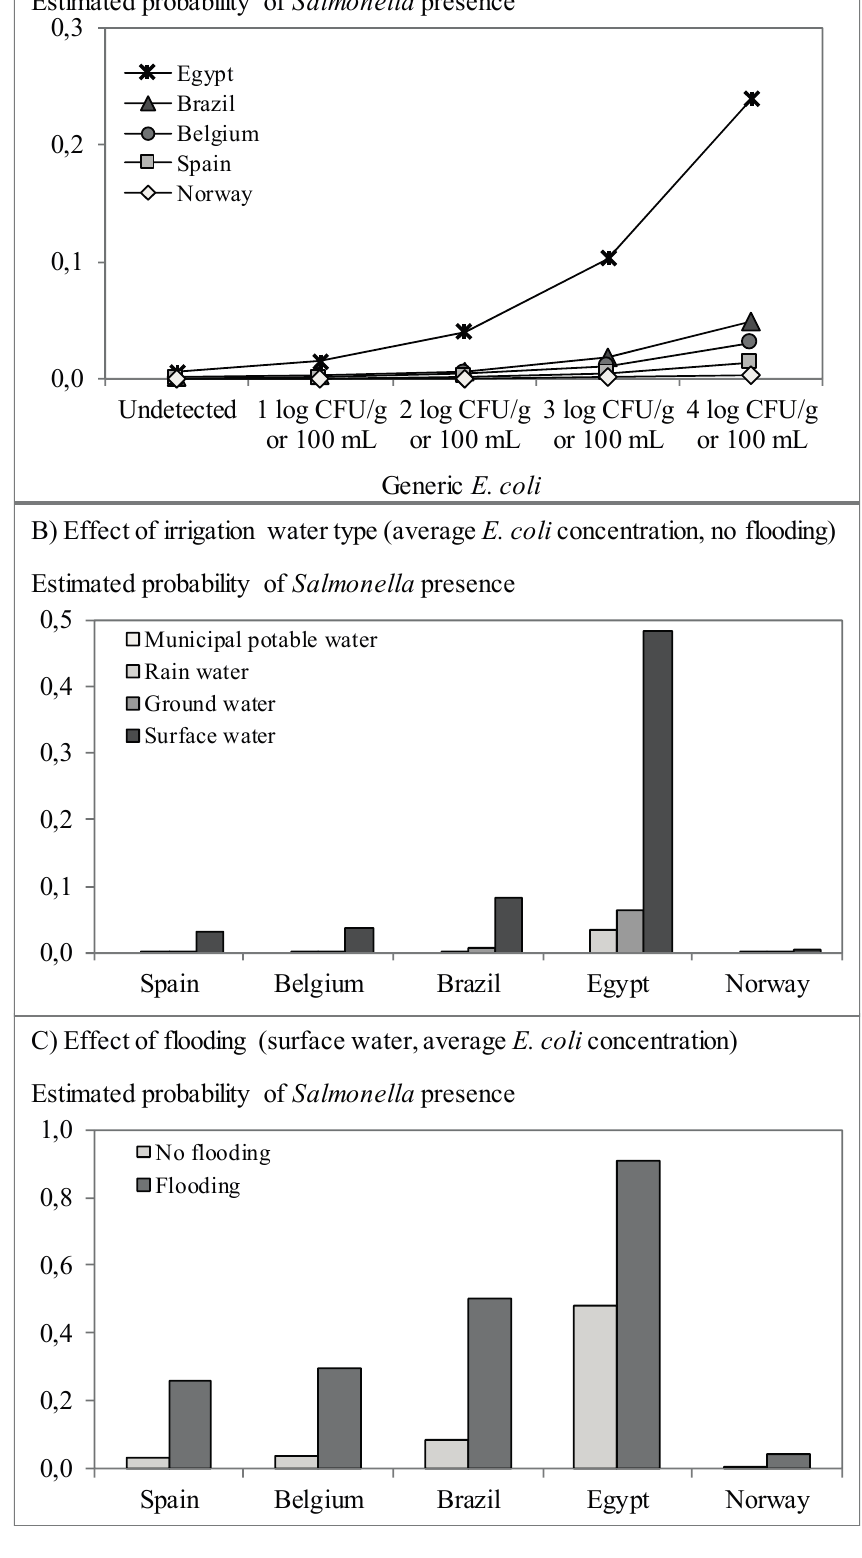
Figure 2. ( a ) Effect of the irrigation water type; ( b ) flooding events; ( c ) generic E. coli concentrations on the estimated risk of Salmonella presence by multiple logistic regression (Table